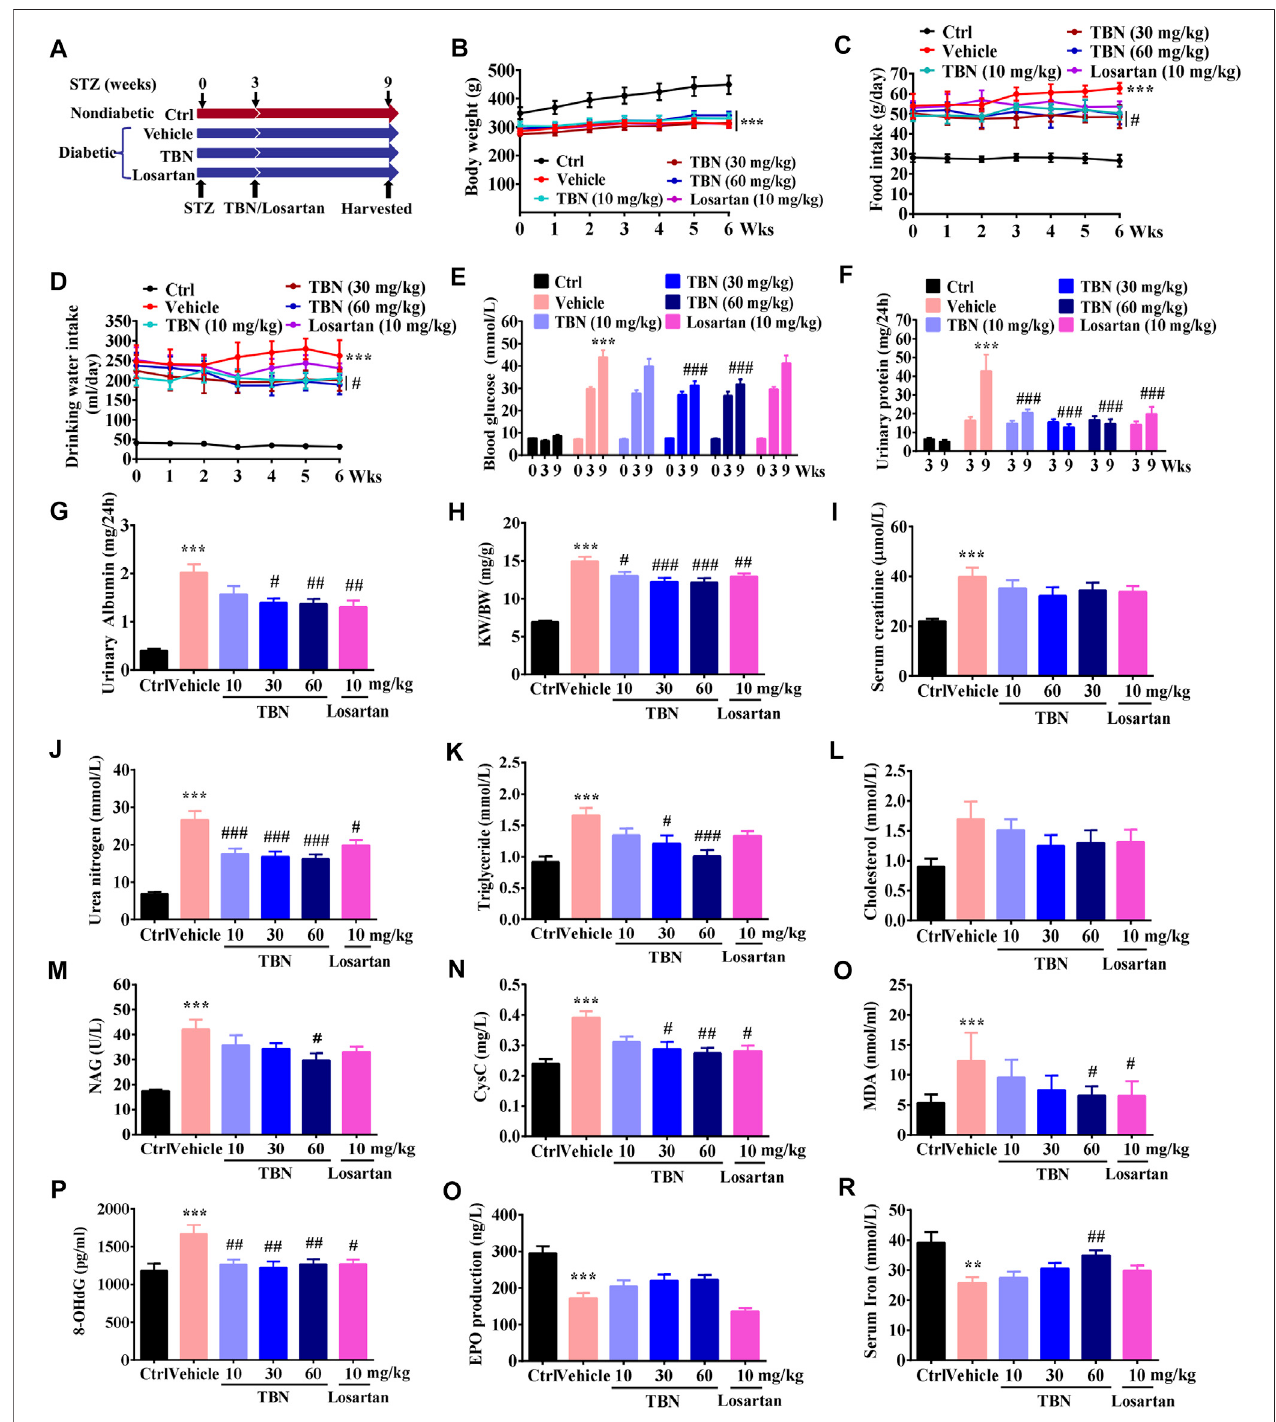
FIGURE1| TBNpreventsDKDinSTZ-inducedrats. (A) TBNorlosartantreatmentprotocolinSTZ-inducedDKDrats. (B) Bodyweight, (C) foodintake, (D) drinking water, (E) blood glucose level, and (F) urinary protein were measured 3 weeks post-STZ injection and 6 weeks post-drug treatment. (G) urinary albuminuria, (H) KW/ BW, (I) serumcreatinine, (J) serumureanitrogen, (K) serumtriglycerides, (L) serumcholesterol, (M) NAG, (N) CysC, (O) MDA, (P) 8-OHdG, (Q) EPO,and (R) serumiron weremeasured after 6 weeks ofdrug treatment. All datawere shown asthe mean ± SEM. Signi fi cance was determined by 2-wayANOVA inB-F or 1-way ANOVA in G-R followed by Tukey ’ s test. ** p < 0.01 and *** p < 0.001 vs. Ctrl group. # p < 0.05, ## p < 0.01, and ### p < 0.001 vs. vehicle-treated group.